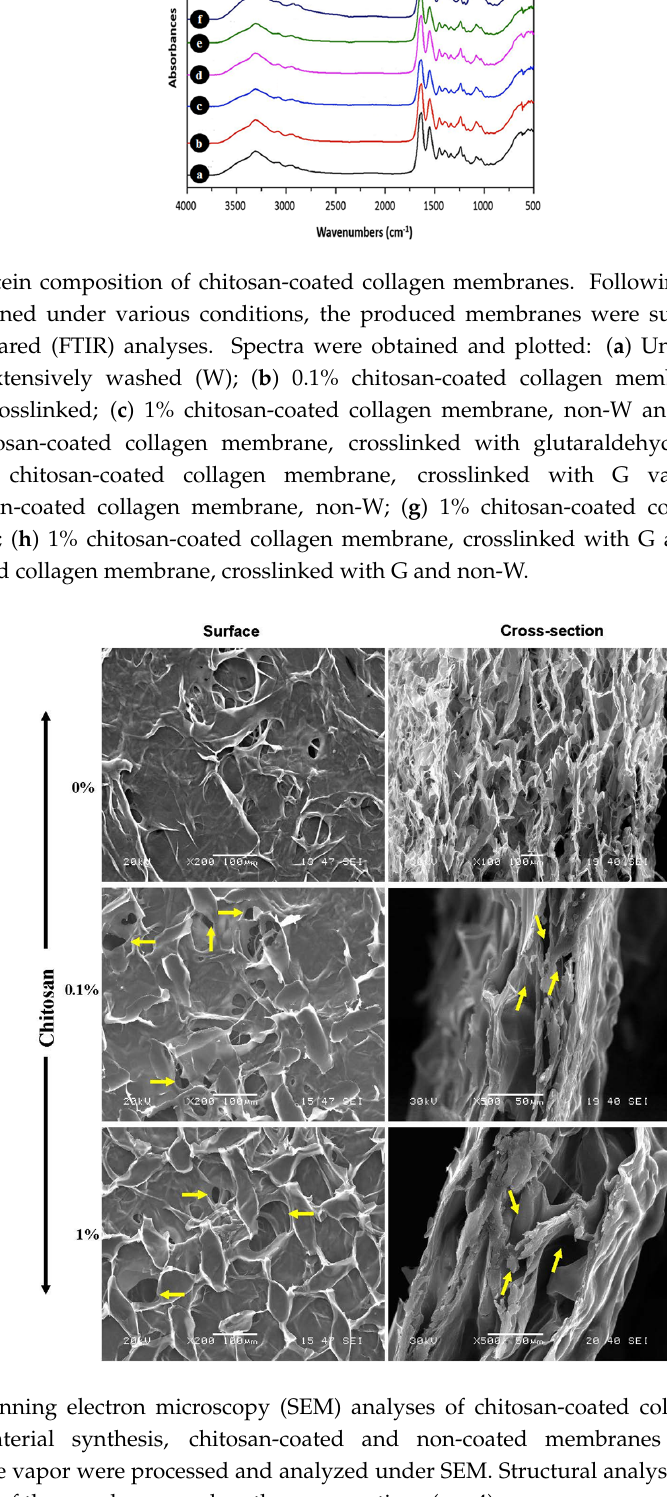
Figure 3. X ‐ ray photoelectron spectroscopy (XPS) spectra of chitosan ‐ coated collagen membranes. Materials with or without chitosan at various concentrations were synthesized and subjected to XPS analyses. Chemical composition spectra of the chitosan ‐ coated and non ‐ coated collagen membranes were compared ( n = 4).